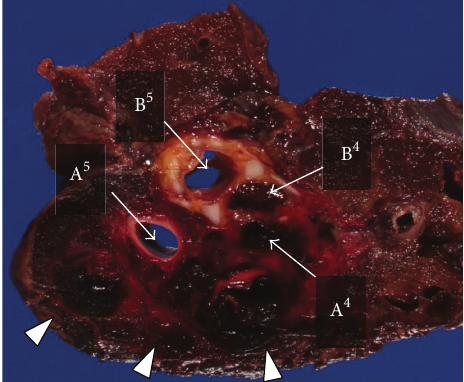
Figure 4: Macroscopic examination of the resected specimen shows disruption of lateral segment artery of the middle lobe of the lung, resulting in a pulmonary hematoma (arrowhead). Lateral segmental bronchus was obstructed by a blood clot. B 4 : lateral segmental bro- nchus; B 5 : medial segmental bronchus; A 4 : lateral segmental artery; A 5 : medial segmental artery.